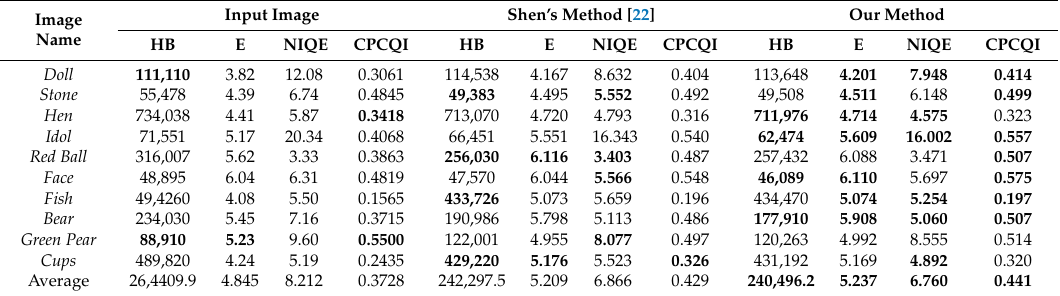
Table 6. Numerical Comparison among Input, HDR using Shen’s method, and Proposed Method.